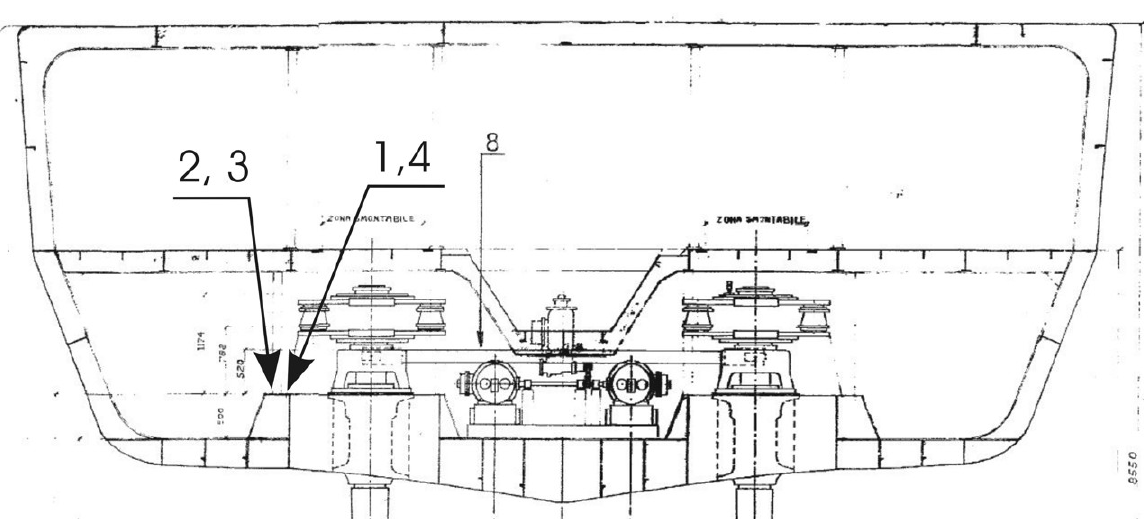
Figure 28: Overlapping of the hull cross sections X-X and Y-Y where the oil-pressure rotary actuators are installed.